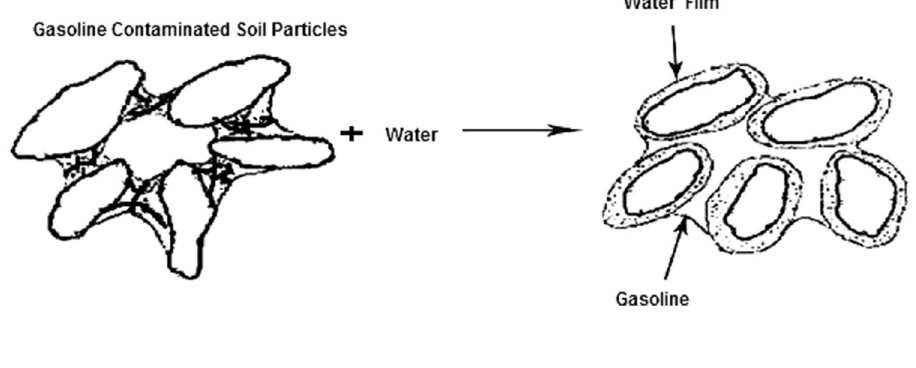
Fig. 31 Schematic of the change in the behavior of the fine-grained part of the studied soil to granular due to diesel